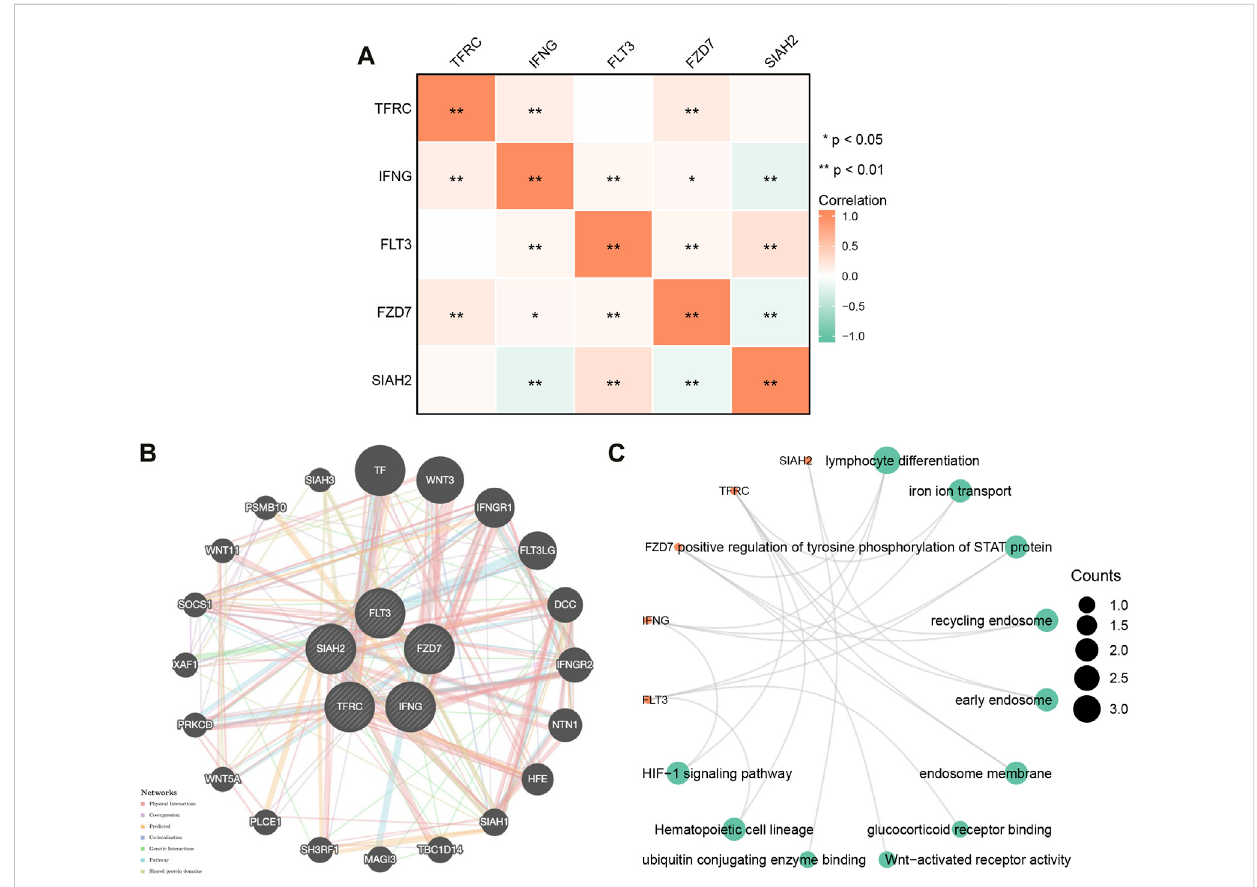
FIGURE 2 (A) Genecorrelationnetworkdiagramofprognosticmodel. (B) Model-relatedgenenetworkplottedusingGeneMANIA. (C) Modelgeneenrichment analysis in pan-cancer: GO and